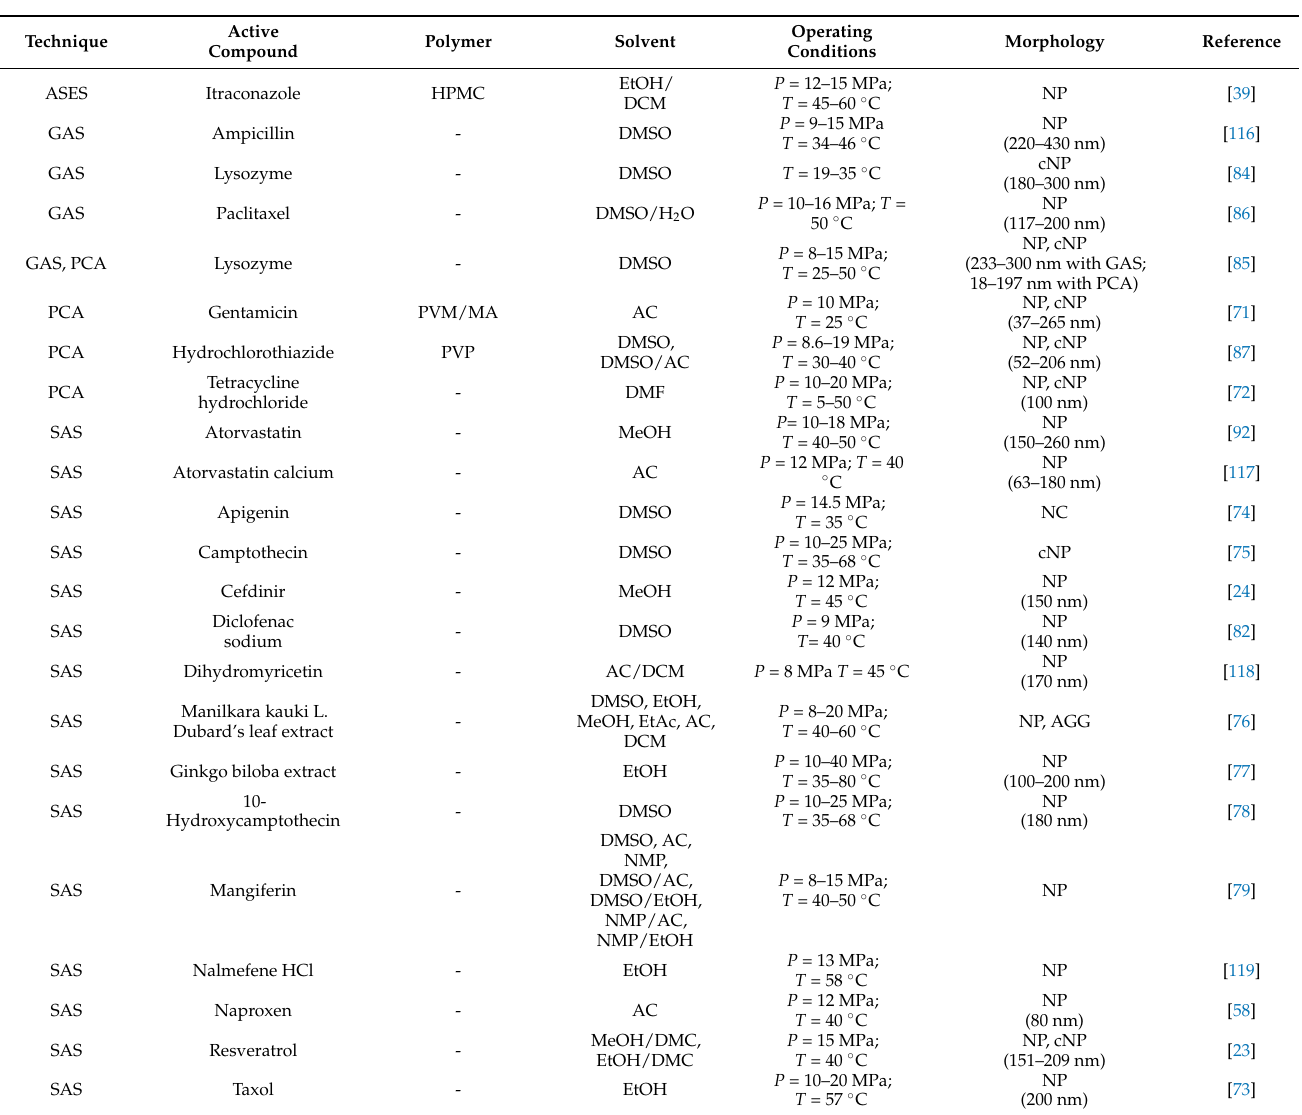
Table 2. An overview of nanoparticle production by using CO 2 as an antisolvent. NP: nanoparticles; NC: nanocrystals; c: coalescing particles; AGG: aggregates; P : pressure; T : temperature; THF: tetrahydrofuran; β -CD: β -cyclodextrin; EC: ethyl cellulose; EL100: Eudragit L100; HP- β -CD: hydroxypropyl- β -cyclodextrin; HPMC: hydroxypropylmethyl